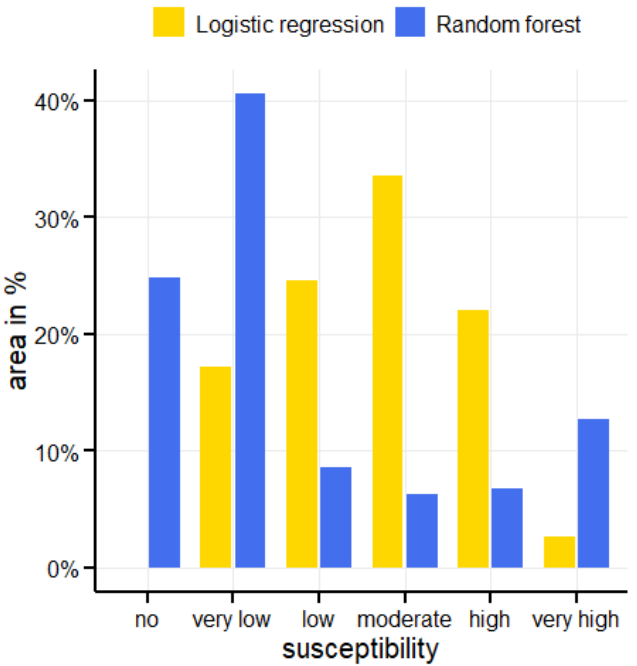
Figure 11. The representation of categories of landslide susceptibility of the area according to models of logistic regression and random